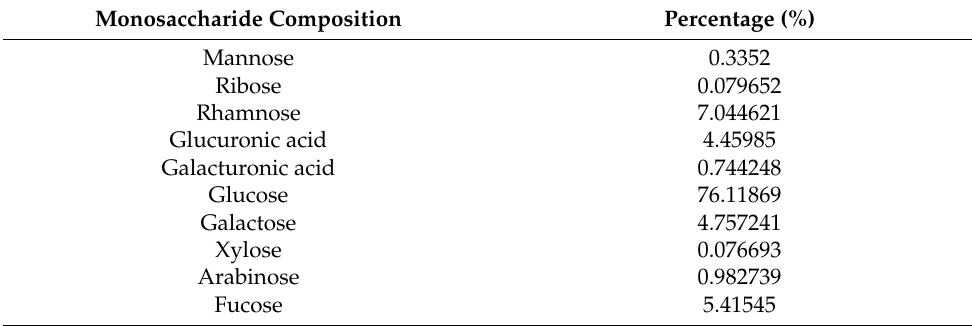
Table 1. The monosaccharide composition of AMP.